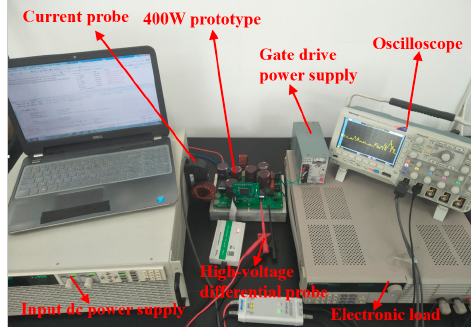
Figure 14. The experiment prototype.